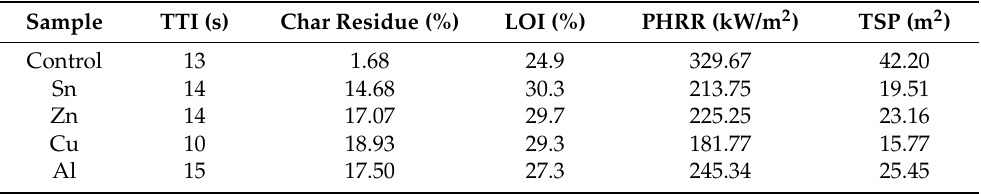
Table 7. Cone calorimetry data for poly(vinylchloride) (PVC)– 5 -metal